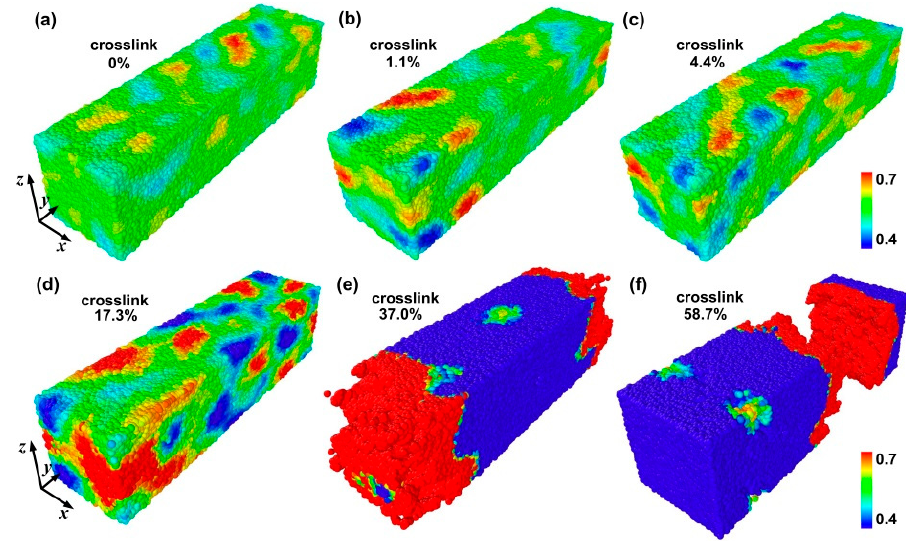
Figure 4. The three ‐ dimensional atomic strain distribution for different crosslink density under tensile strain at T = 0.1. ( a ) Linear polymer; ( b ) 1.1% crosslink density; ( c ) 4.4% crosslink density; ( d ) 17.3% crosslink density; ( e ) 37% crosslink density; and ( f ) 58.7% crosslink density.